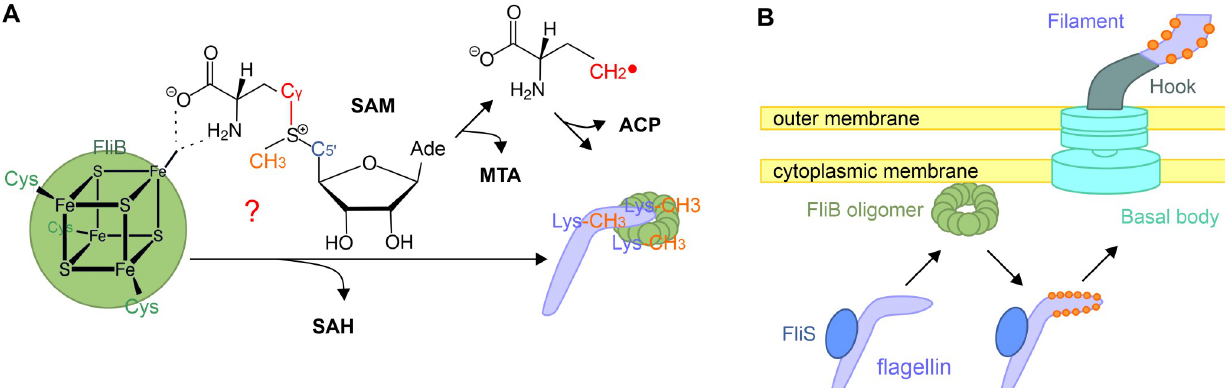
Fig 5. The proposed reaction mechanism for FliB. ( A ) The mechanism assumes two roles of SAM binding to [4Fe-4S] in FliB: One SAM is converted into an ACP radical and facilitates the methyl transfer from the other SAM molecule to the flagellin substrate. ( B ) The postulated process illustrates that the flagellin subunit bound by its chaperon FliS is delivered to the FliB oligomer near the cytoplasmic membrane. The Salmonella FliB complex methylates accessible lysine residues in flagellin domains D2 and D3 before protomer secretion and flagellar assembly.